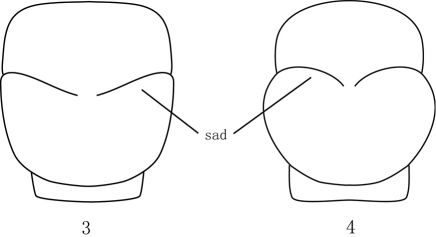
Pronotum 3 Tillicera cleroides, showing pronotum gradually narrowed after subapical depression 4 Tillicera sensibilis sp. n., showing pronotum swollen after subapical depression sad = subapical depression.